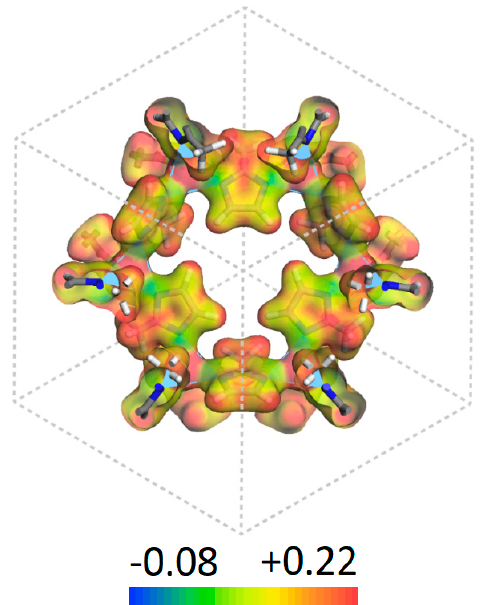
Figure A1. Electrostatic potential map obtained at BLYP/DN level on the X-ray resolved structure of ZIF-8 reported in Ref. [27] and plot on the 0.2 a.u. isosurface. The values of − 0.08 and +0.22 au are reported in blue and red, respectively, with intermediate values reported in a reverse rainbow scale. The atoms are reported in the same color code as in Figure 1.